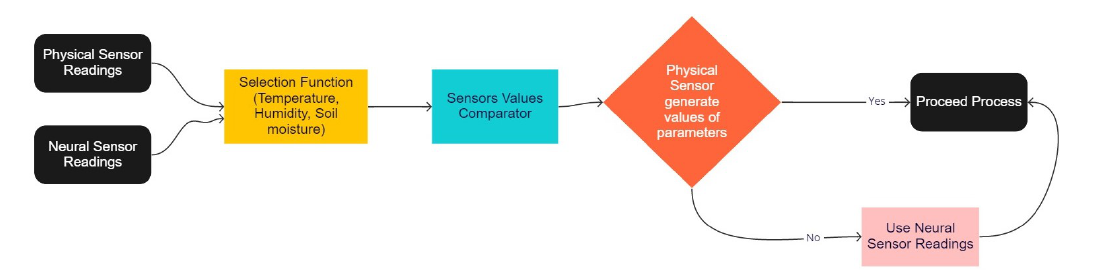
Figure 1. The flowchart of the proposed model for the flow of the SIS system in the presence of the proposed neural sensor node. The system is fed with the values from the physical sensor and neural sensor values simultaneously. The comparator module compares both the values. If the physical sensor value deviates from a neural sensor node by a huge margin, then a red flag is raised regarding the physical sensor and the neural sensor value is passed to the SIS system to save it from experiencing a drastic degradation in